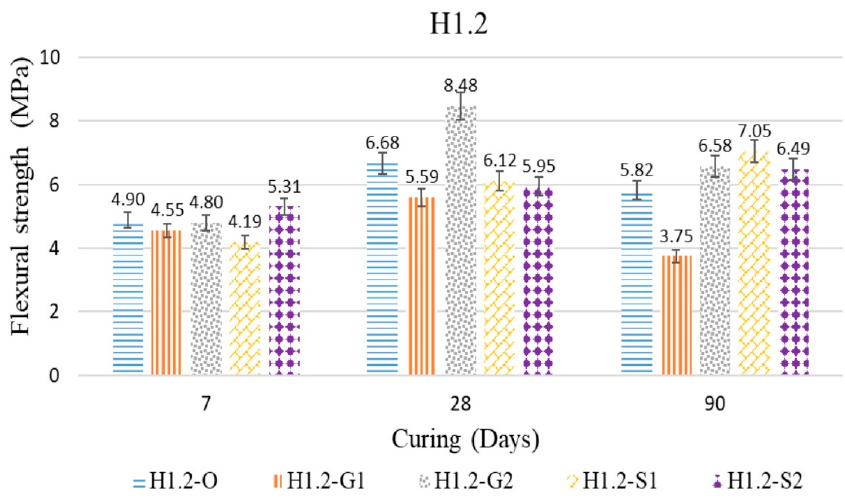
Figure 12. Flexural strength results for H1.2 high-strength pervious concrete specimens.